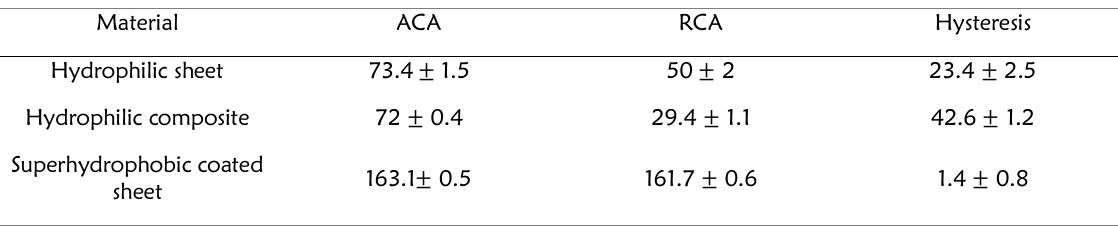
Table 3: The Advancing contact angle (ACA) and Receding contact angle (RCA) were measured using a goniometer. The droplet volume increased and decreased with 0.08ul/sec to obtain quasi-static